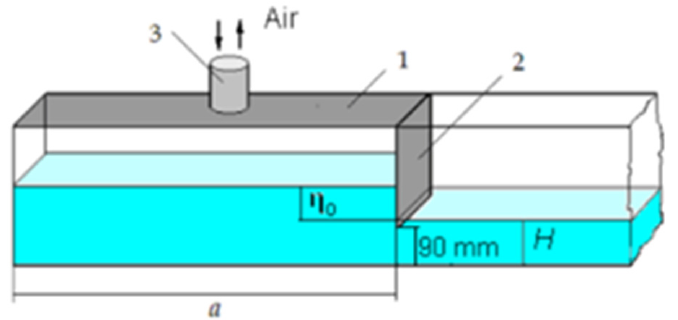
Figure 4. Schematic drawing of the caisson-type generator. In the top cover of the wave generator, there is a tube (3) provided for pumping out and filling with the air the upper volume of the generator, while the 90 mm high lower part of the generator communicates with the effective volume of the channel. Before the operation, the channel is filled with water up to the level of H 0 > 90 mm. Then, the air is evacuated via tube (3) from the upper part of the generator, thereby attaining specified water level difference η 0 : the water level ( H + η 0 ) in the generator and the water level H in the working part of the channel. After depressurization ( t = 0) of the upper part of the generator, the wave is initiated in the working part of the channel. The wave has the length L ≈ 2 a and the amplitude A ≈ η 0 /2 (see Appendix A). Let us refer to the wave generator, which at the time t = 0 instantly retracts the front wall, as an ideal one. The work of the ideal generator and the real (caisson-type) one was compared using numerical simulation. At a distance x > a from the front wall of the generator, calculated profiles of gravity wave ξ ( t ) of the ideal generator and the caisson-type one were almost identical. The process of tsunami-type wave generation in the hydrodynamic channel (wave flume) of the IPRIM RAS is shown in Figure 5. At the initial moment of time t = 0, the process of decay of a given level difference δ 0 = 2A is started. Up to this point in time, the water in the generator and the working channel was at rest. At t = 0.7 s, we see that the initial level difference split into two waves: a negative wave ( − A ) moves inside the generator ( a = 1.465 m), a wave with a height (+ A ) moves into the working part of the hydrodynamic channel. In each image, above the white horizontal line, we can see the profiles of the water levels in these waves, below the longitudinal velocity. Further, at t = 2 s and t = 3.3 s, we see that the wave ( − A ) reflected from the generator wall and formed a single wave with height (+ A ) and length L = 2 a , which moves into the working part of the (cid:112) gH = 1 m/s. The velocity of liquid in the channel wave flume. The wave speed is c = before and after the wave was